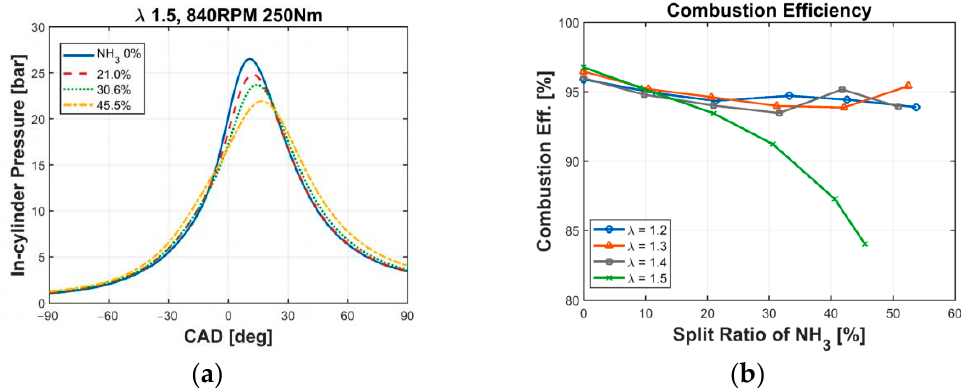
Figure 3. Effect of ammonia volume fraction. ( a ) on the maximum pressure in the cylinder; ( b ) on comustion efficiency in different excess air coefficients.